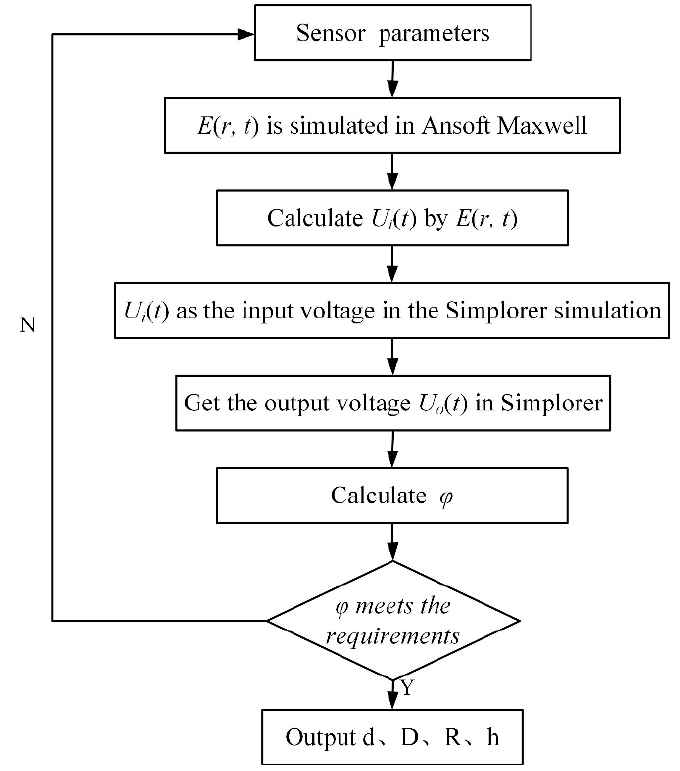
Figure 5. Joint simulation flow chart of the Field-Circuit analysis method.